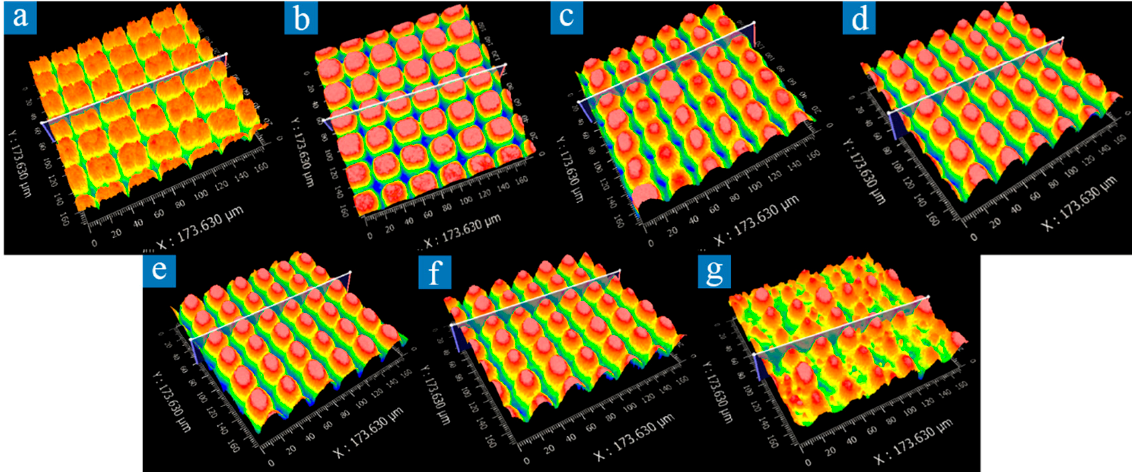
Figure 6. Three-dimensional topography of aluminum alloy surface captured by a white light interferometer under different laser power. Length in the images is 173.63 μ m. ( a ) 27 W; ( b ) 28.8 W; ( c ) 30.6 W; ( d ) 32.4 W; ( e ) 34.2 W; ( f ) 36 W; ( g ) 37.8 W.